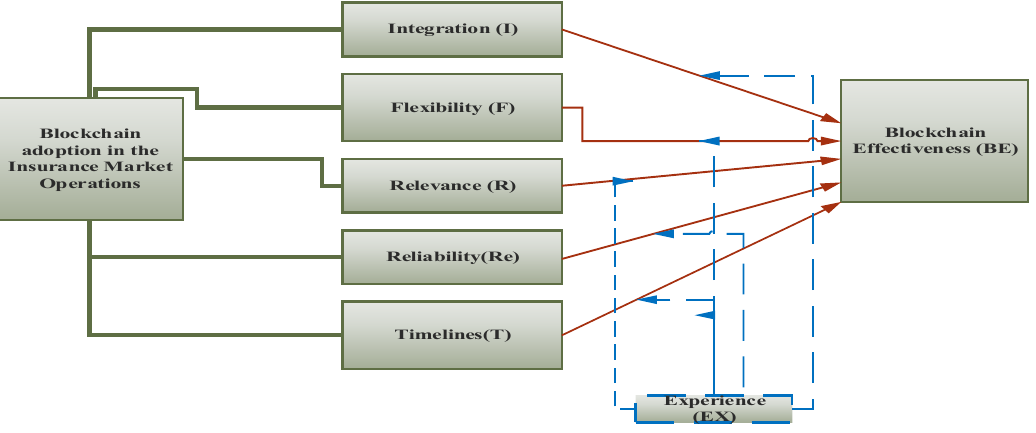
Figure 1. The conceptual model (Source: authors’ compilation). Table 3. List of statements on blockchain perceived effectiveness (Source: authors’ compilation). I. Dependent Variable Blockchain Effectiveness.